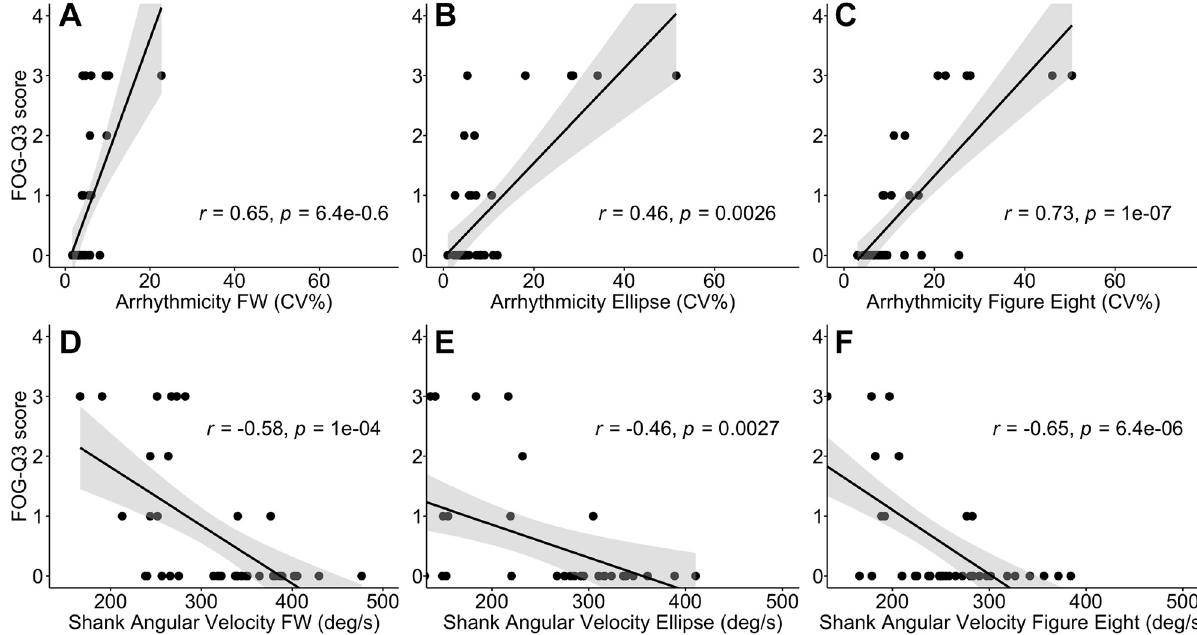
Fig 3. Relationship between gait parameters and freezing of gait questionnaire question 3 (FOG-Q3) during walking tasks. Correlation with FOG-Q3 between A–C : gait arrhythmicity, and D–F : shank angular velocity, during FW (A, D), TBC ellipses (B, E), and TBC figures of eight (C, F) . Regression lines (black line) and confidence intervals of the correlation coefficient at 95% (shaded grey), and subjects (black dots) shown.